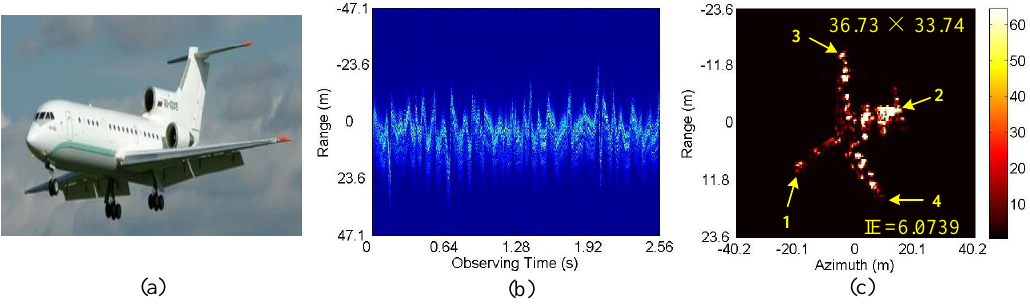
Figure 9. Real data of Yak-42 airplane. ( a ) Optical image. ( b ) HRRPs. ( c ) The ISAR image obtained by the proposed framework.